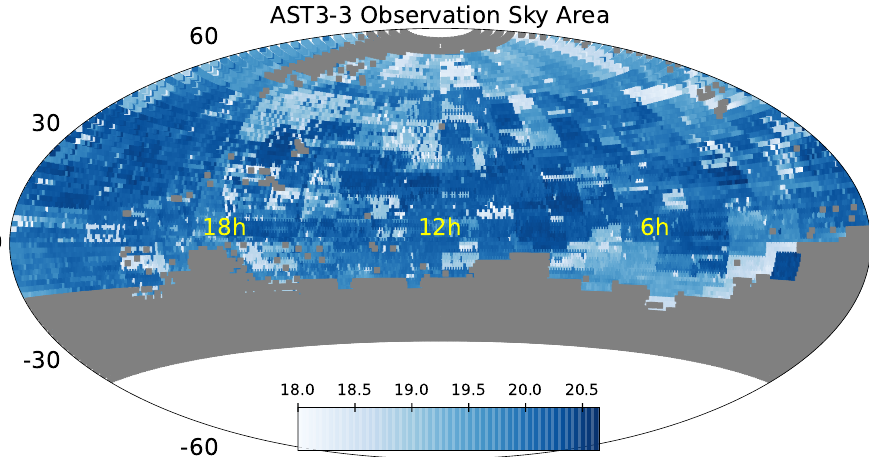
Figure 6. AST3-3 Survey Sky area grids and the magnitude for the prepared template images till now. The magnitude limits are coloured with depth to show that most templates are deeper than 19.0